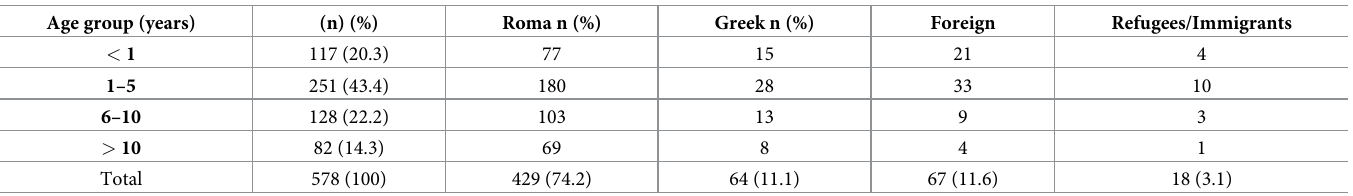
Table 1. Number and percentage of measles cases by age group and origin, 8/2017-10/2018 (n = 578). Age group